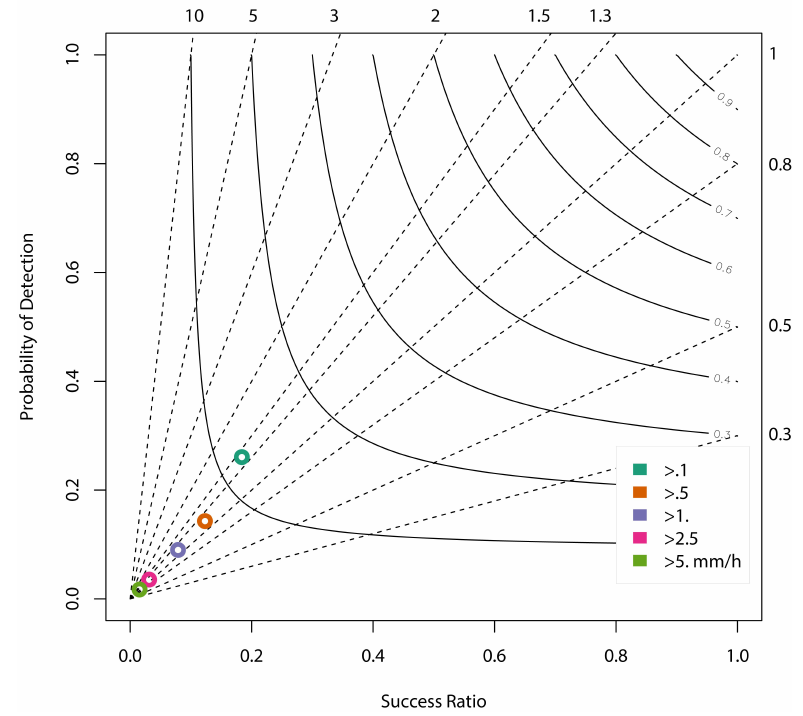
Figure 3. Model performance for hourly rainfall for entire study period and all stations.